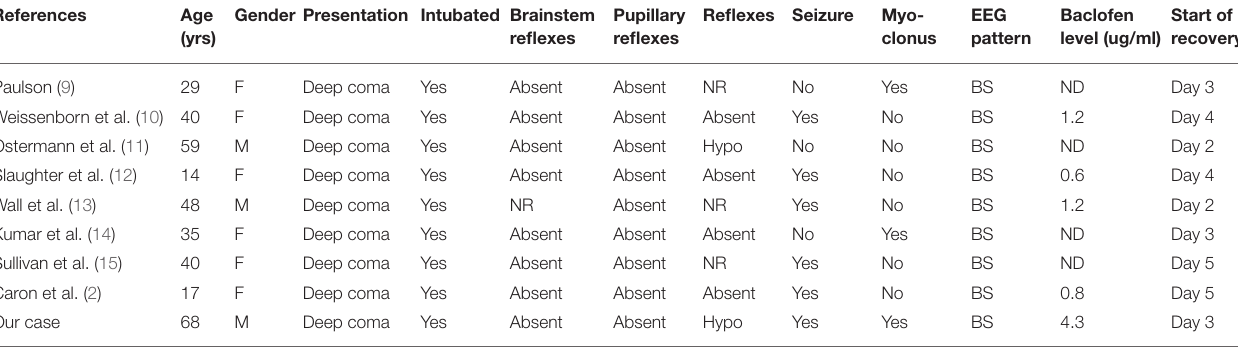
TABLE 1 | Clinical characteristics of published cases of baclofen intoxication with a BS pattern on